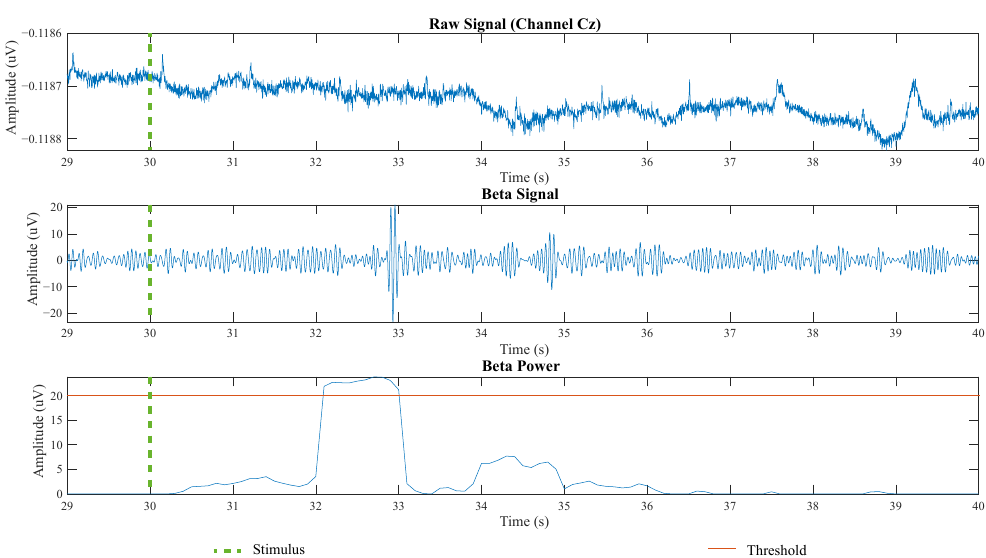
Figure 6. Processing results over 10 s of an MIVH active period to detect the beta rebound signal. First, the raw signal over channel Cz appears. The second signal refers to the filtered wave in the beta frequency band (16–24 Hz). The last signal shows the beta signal squared and averaged compared with the threshold (horizontal orange line). The dotted and vertical green line refers to the moment in which the stimulus was given.